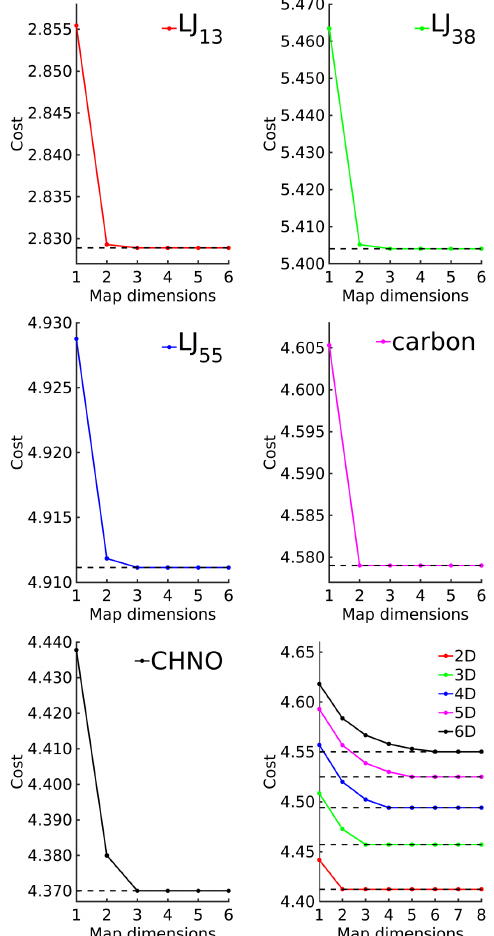
FIG. 13. Lowest cost obtained through SHEAP projections (without hard-sphere interactions) of datasets of 10 000 local minima for five systems, plotted against the number of map dimensions. Also shown are (lowest) cost versus map dimension plots for 10 000 points drawn uniformly at random inside the unit hypercubes of 2 – 6 dimensions, on a single set of axes. Each SHEAP projection uses a perplexity of